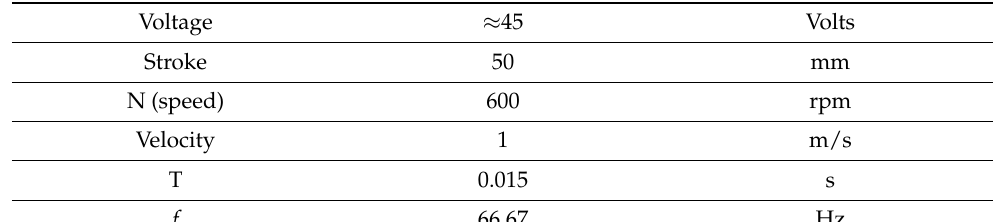
Figure 24. Back EMF at 600rpm with peak of ~ 1 m/s.